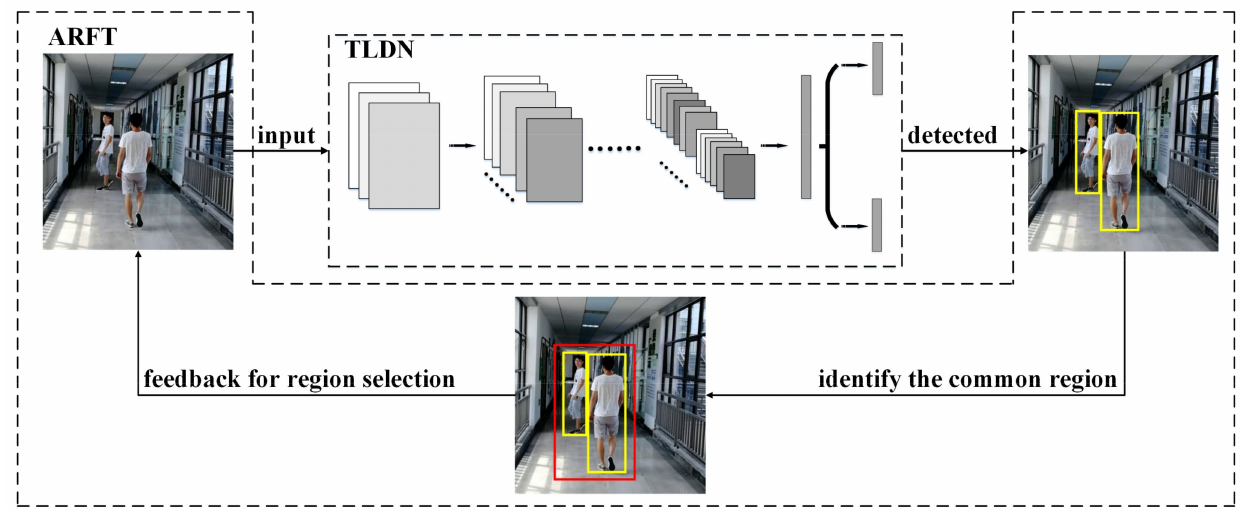
Figure 1. Overall architecture of the proposed method.